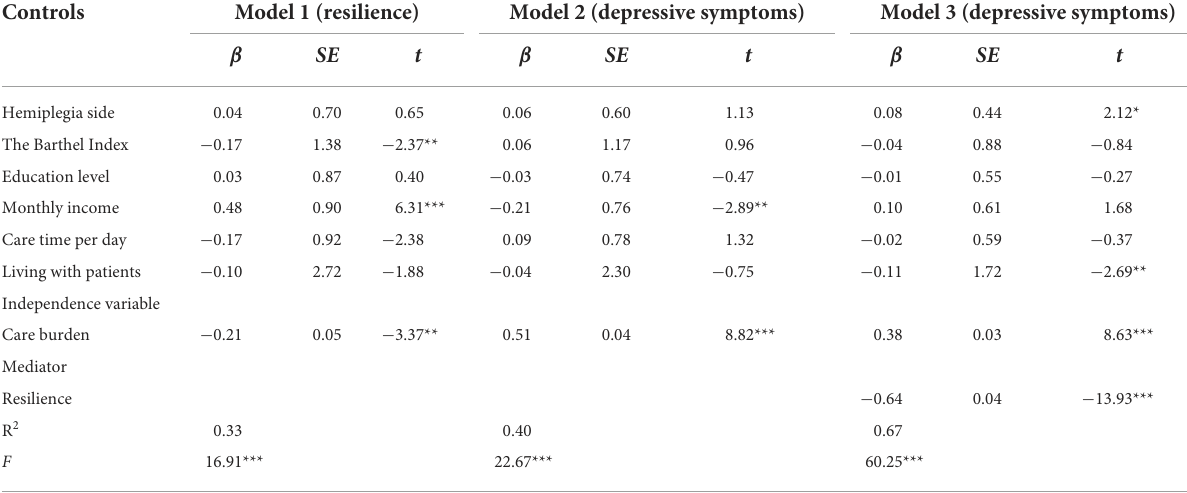
TABLE 3 Mediating effect of resilience between care burden and depressive symptoms.